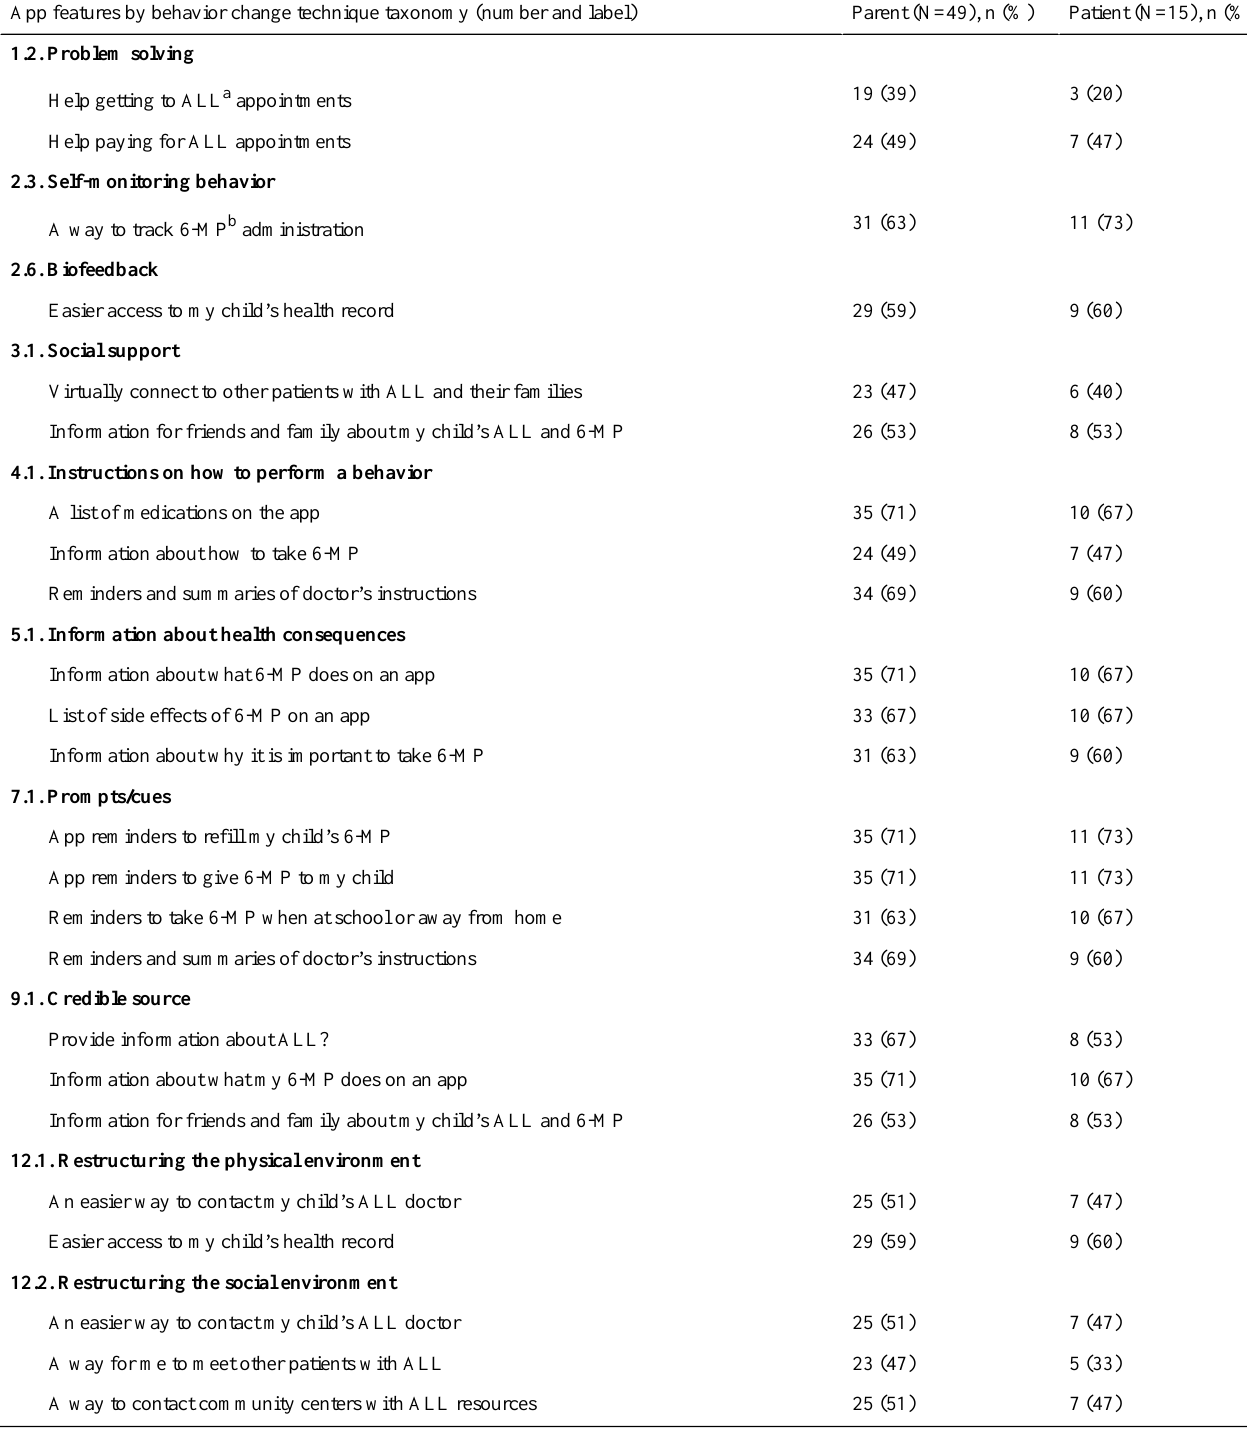
Table 3. Participants’interest in mHealth behavior change techniques focused on promoting medication